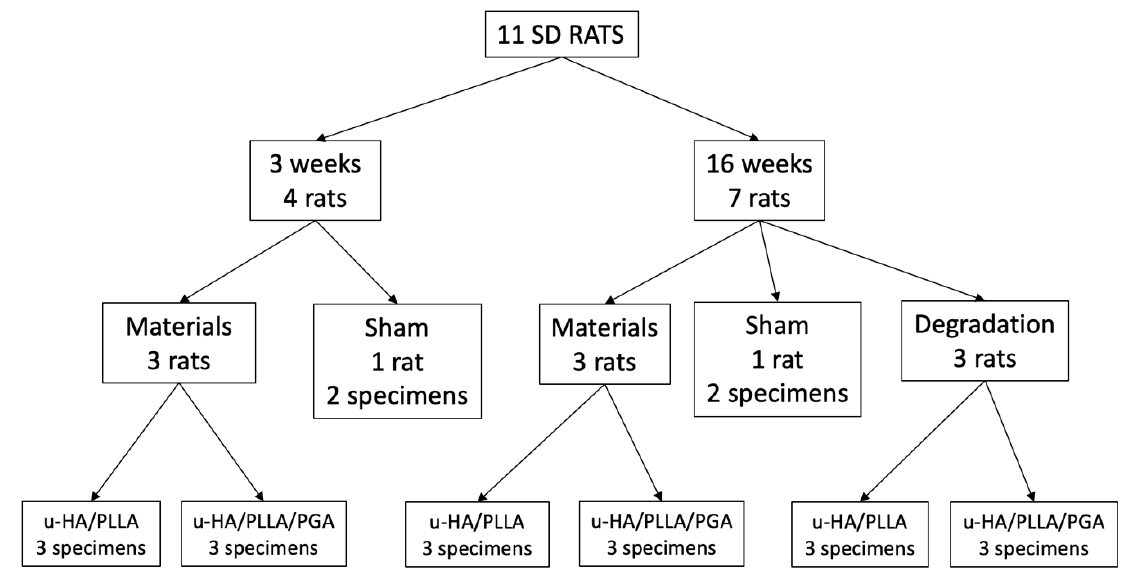
Figure 2. Experimental groups.